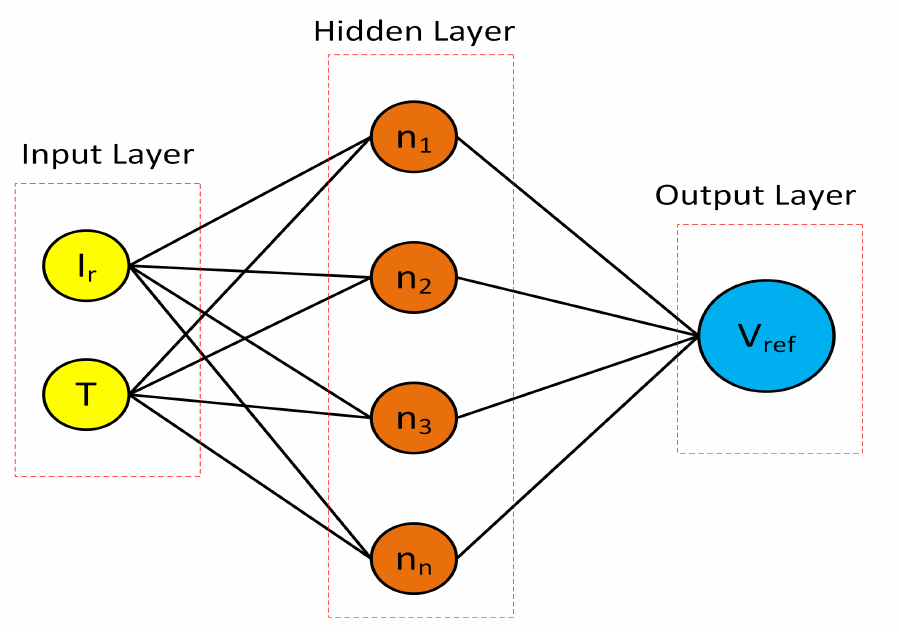
Figure 5. Internal architecture of NN.